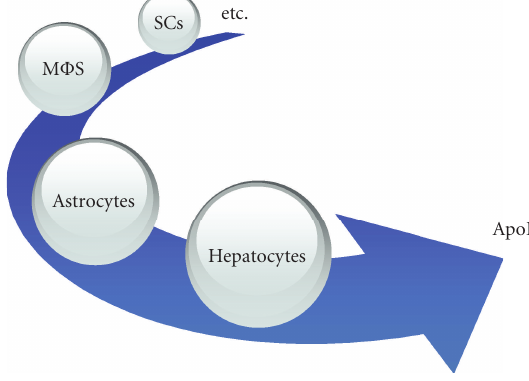
Figure 1: The synthesis and secretion of apoE are found in spleen, brain, lung, kidney, peripheral nerves, muscular tissue, adrenal, ovary and testis, and so forth. Hepatic parenchymal cells are the principal apoE-producing cells in mammalians, presumably accounting for 60% to 75% of plasma apoE, followed by astrocytes, which are the main apoE-producing cells in the brain, macrophages (M Φ s), and nonmyelinating Schwann cells (SCs), and so forth.